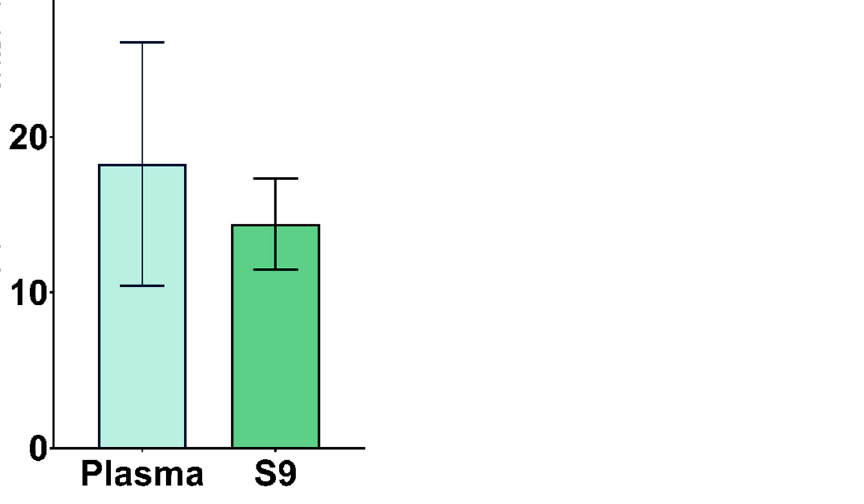
Figure 3. Specific activity of glutathione S-transferase (GST) in plasma and S9 (nmol min − 1 mg PROT − 1 ) of white stork ( C. ciconia ) nestlings ( n = 16), presented as the mean ± SD. A decrease in glutathione reductase (GR) absorbance (OD) was observed in plasma and S9 (Figure S5) for the 10-min time period. Different sample concentrations and measurement times were tested, and the final values used are based on a linear absorbance increase and R 2 ≥ 0.95.